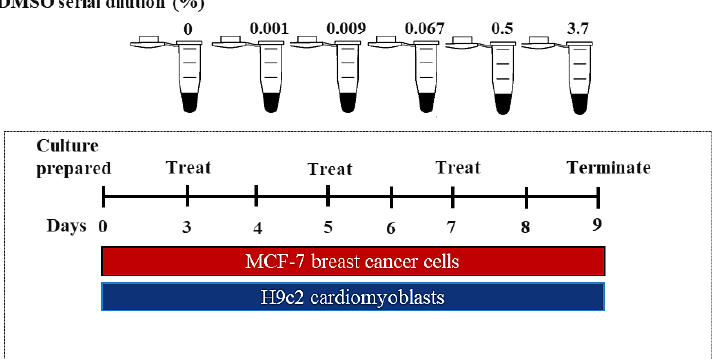
Figure 6. An in vitro experimental design of dimethyl sulfoxide (DMSO) exposure on H9c2 cardiomyoblasts and MCF-7 breast cancer cells. Concisely, cells were treated with varying DMSO concentrations (0.001 0.009, 0.067, 0.5, and 3.7%) for 6 days. Treatment was terminated on day 6 and biochemical analysis were conducted.